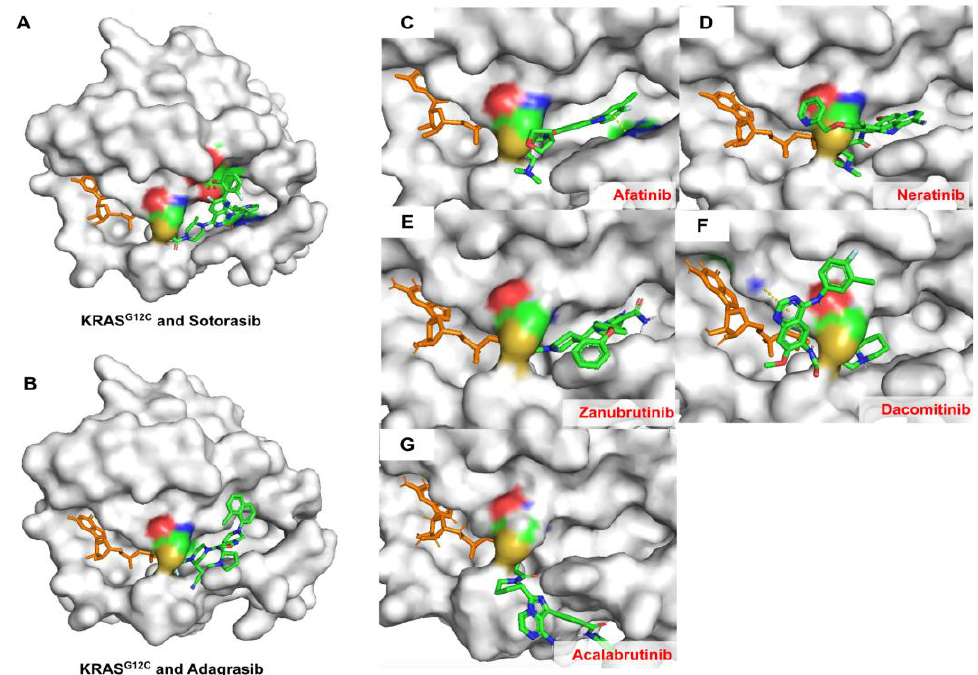
Figure 8. Covalent docking of all 7 compounds with KRAS G12C (PDB: 6OIM). The compounds include ( A ) sotorasib, ( B ) adagrasib, ( C ) afatinib, ( D ) neratinib, ( E ) zanubrutinib, ( F ) dacomitinib, and ( G ) acalabrutinib. The predicted compounds are represented in green, blue, and red colors based on carbon, nitrogen, and oxygen atoms, respectively. The guanosine diphosphate (GDP) is presented in orange color while the KRAS G12C is represented in white color. The cysteine residue 12 is represented in yellow color on the protein surface.